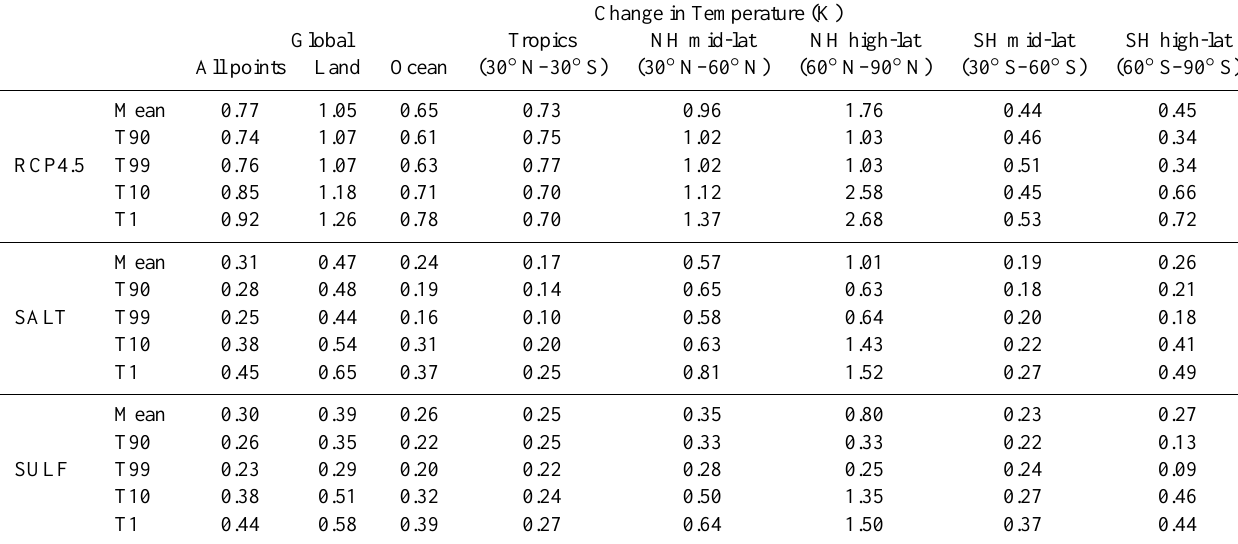
Table 2. Change in temperature 2040 to 2069 minus the RCP4.5 control period (2006–2035).